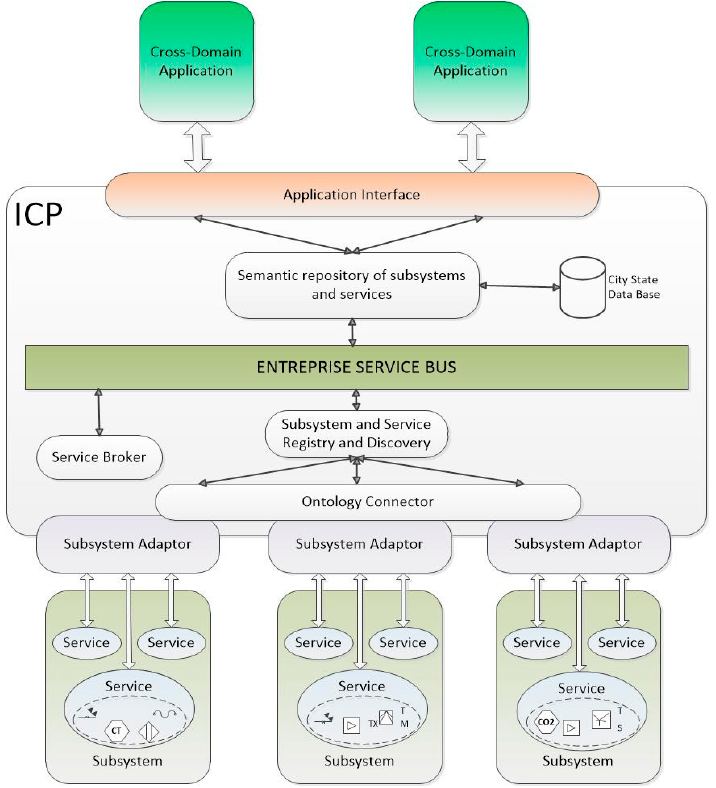
Figure 10. Proposed Integration and Coordination Platform regarding Semantic Interoperability.